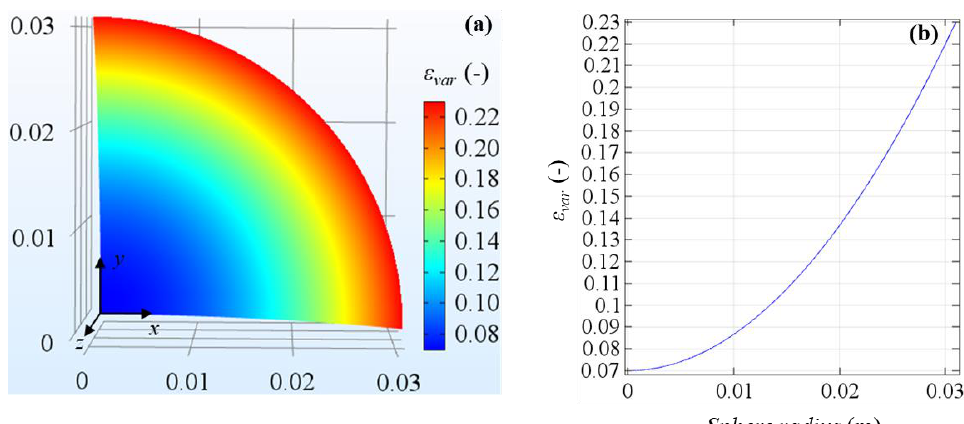
Figure 3. Variable porosity field in tumoral tissue domain ( a ) and porosity profile on the sphere radius ( b ). Furthermore, Q ext in Equations (1) and (2) represents a generic external power